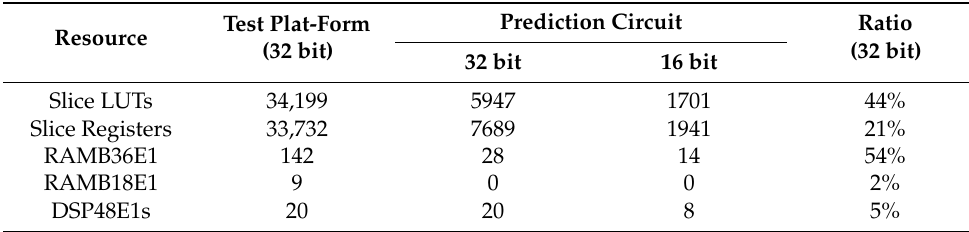
Table 1. PL Hardware Resource Cost.